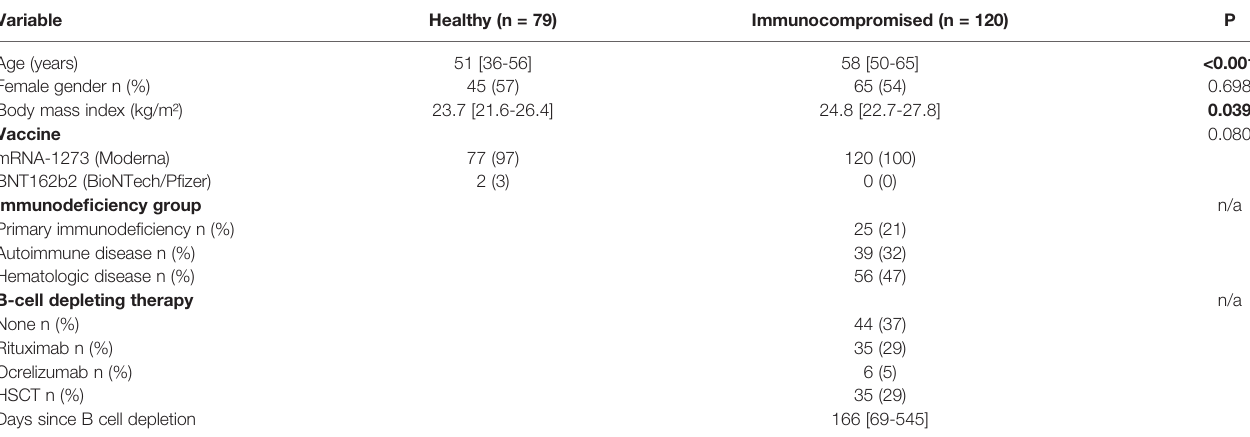
TABLE 1 | Baseline characteristics of the study